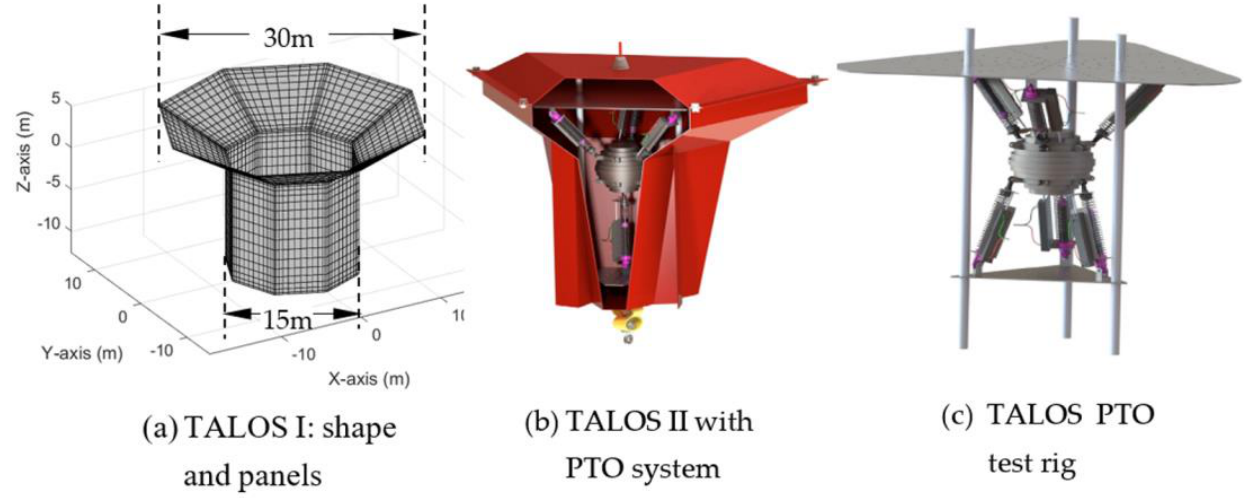
Figure 1. TALOS I structure/panel ( a ); TALOS II and the multi-axis power take-off (PTO) ( b ); and TALOS PTO test rig ( c ).